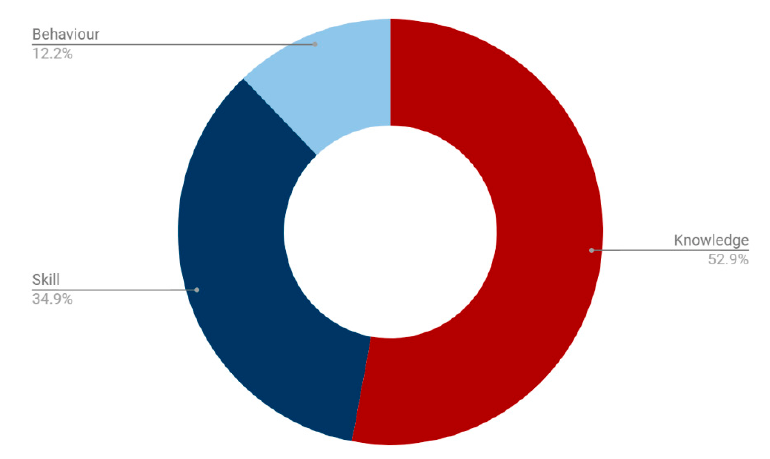
Figure 4. Proportion of nutrition-related objectives designated as knowledge-, skill-, and behaviour-based outcomes.